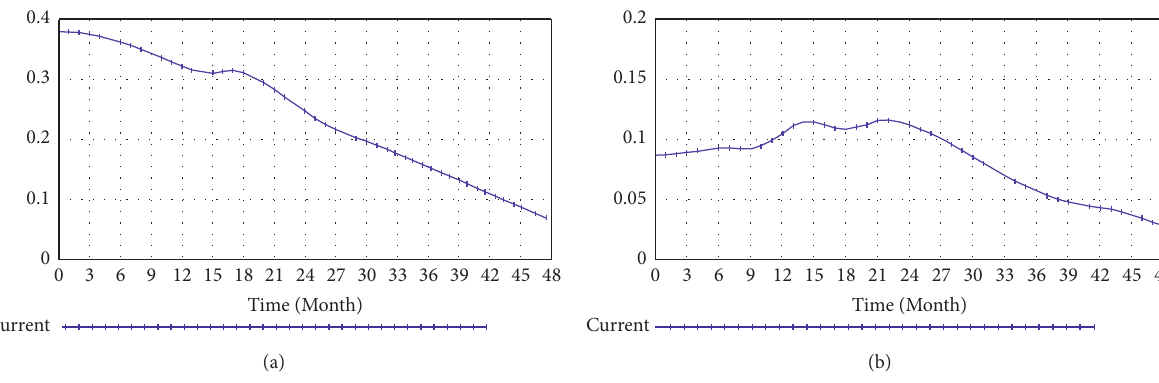
Figure 7: Developing trend of risk categories. (a) Developing trend of investigation factors. (b) Developing trend of technology factors. Table 4: Top 10 sensitive safety risk